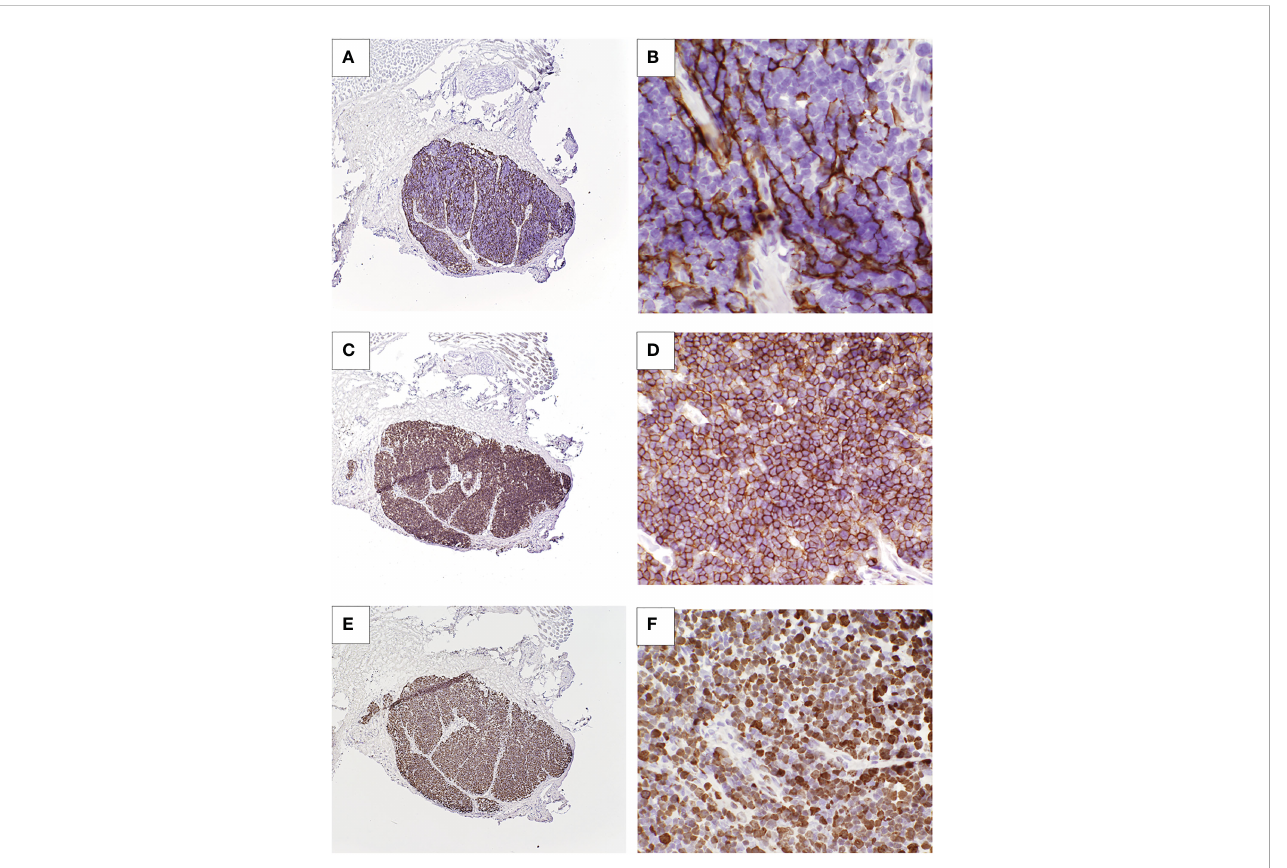
FIGURE 2 Cultured thymus tissue biopsy of patient 1. (A, B) Immunohistochemistry with anti-cytokeratin AE1/AE3 antibody shows thymic epithelial cells. (C, D) Anti-CD1a staining shows presence of thymocytes. (E, F) Staining for Ki-67, an intracellular marker for proliferating cells, show that these thymocytes are